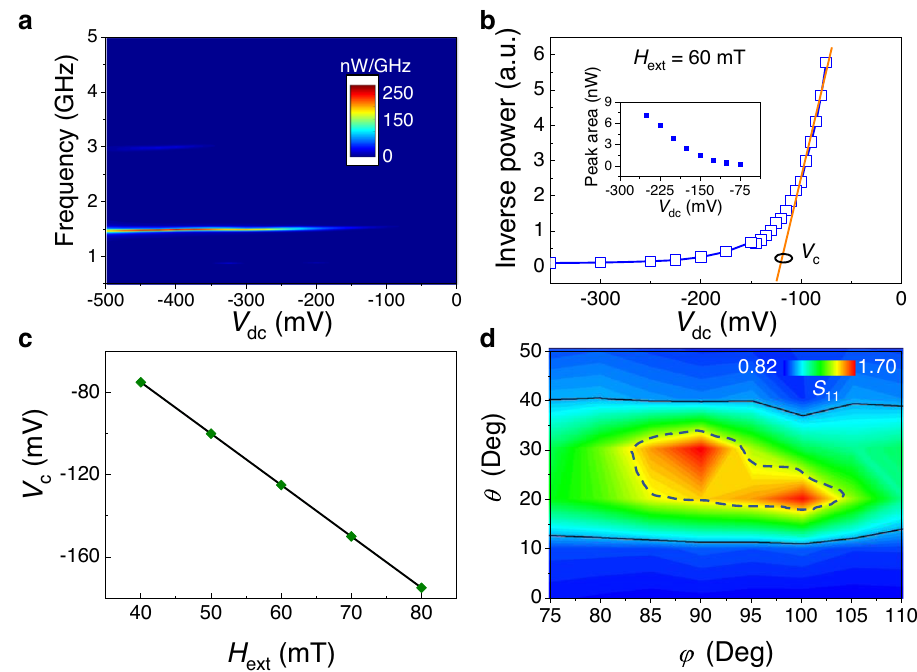
Fig. 2 | Microwave emissions and ampli fi cation dependence of the MTJ. a Microwaveemissiondrivenbythebiasvoltage V dc . b Inversemicrowavepoweras a function of the input voltage and the linear approximation at small input power (orangecurve).Thecriticalvoltage V c canbecomputedfromtheintersectionofthe orange curve with the voltage axis, which gives a value of − 125mV for this fi eld con fi guration. Inset. Microwave power computed as the integral of the excited